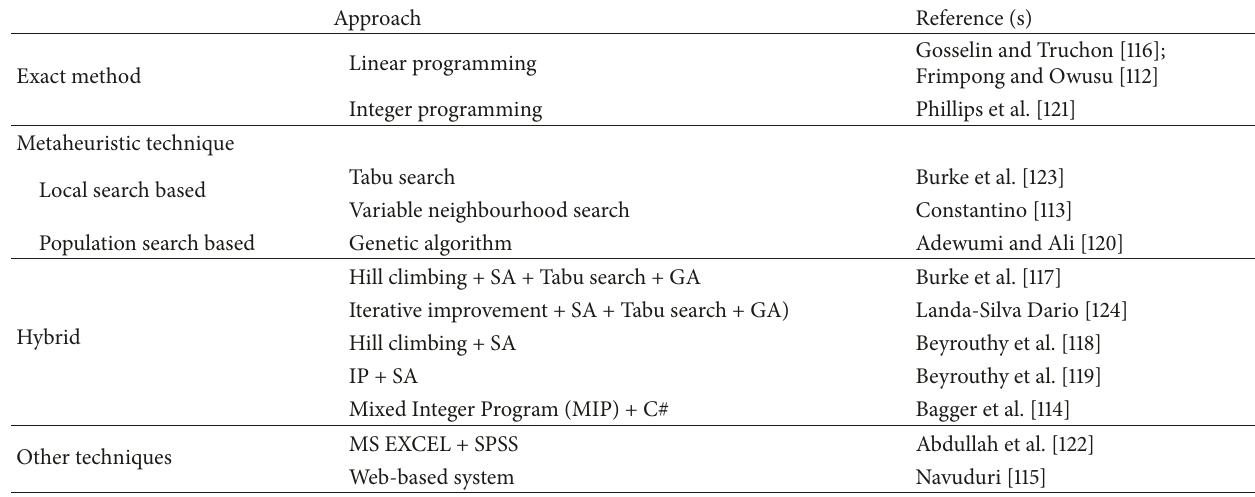
Table 18: Summary of studies related to